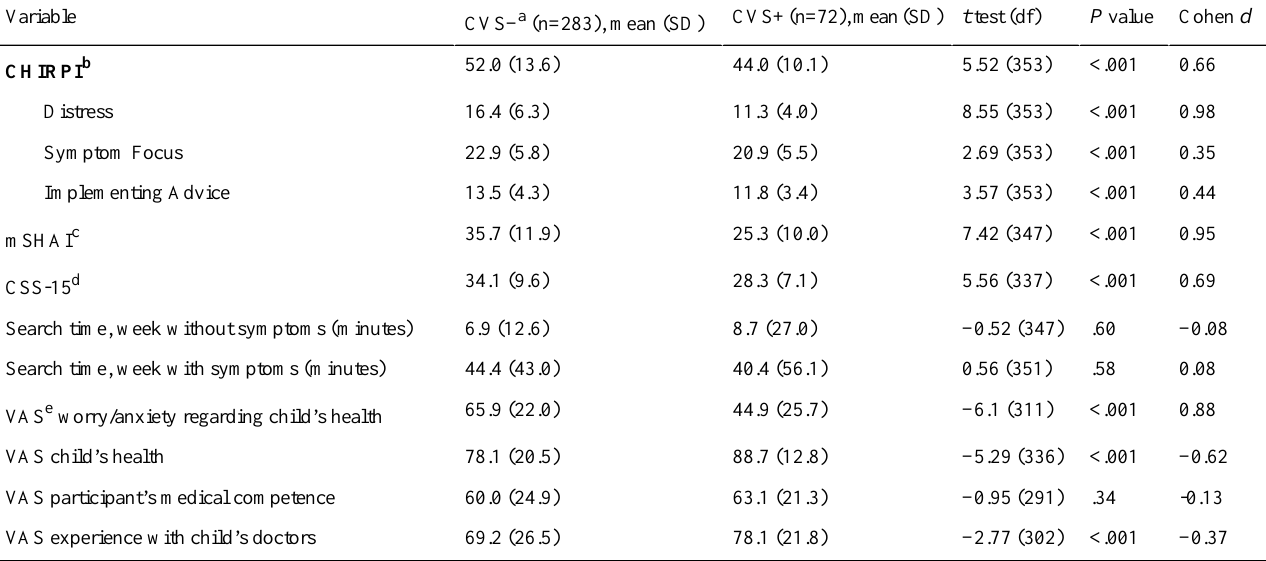
Table 6. Comparison of parents above (CVS+) and below (CVS−) the cutoff for the Child Vulnerability Scale using independent samples t